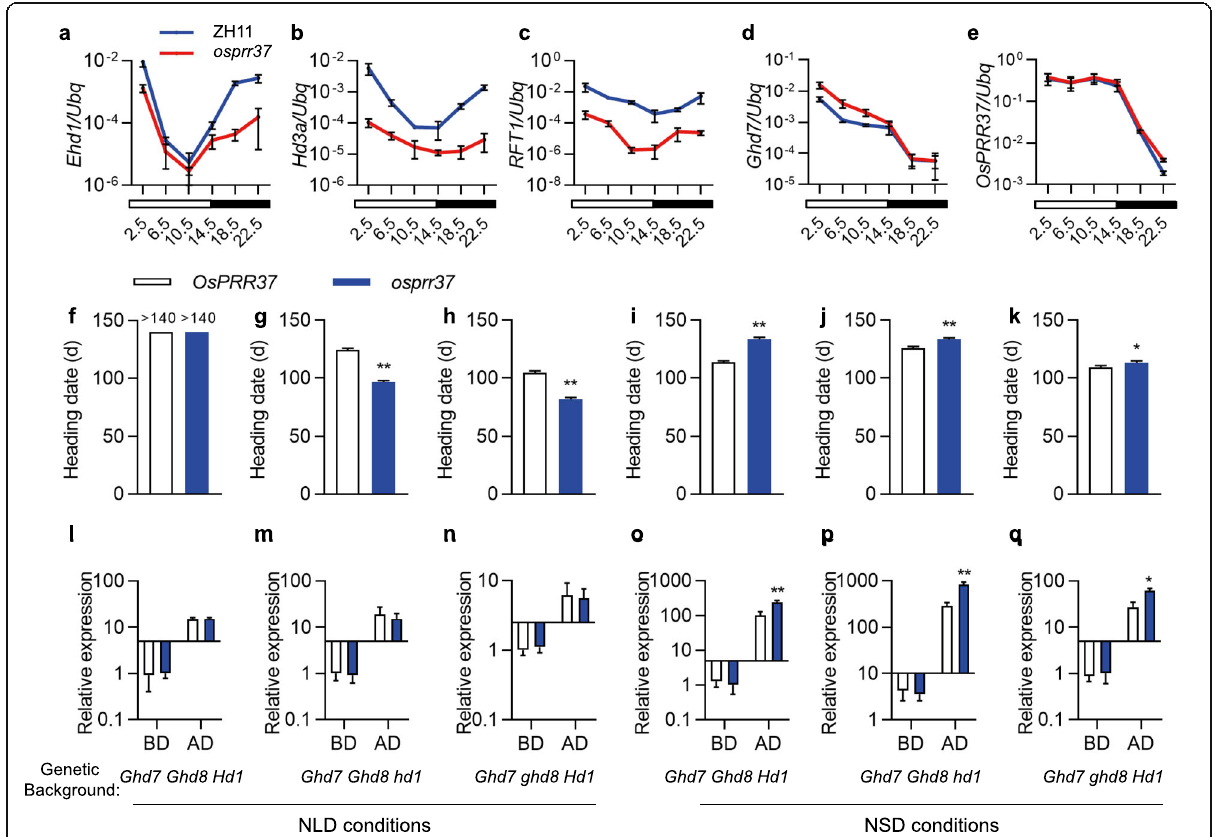
Fig. 3 Expression analysis of heading date genes in osprr37 mutant and different NILs. a-e Log 10 -transforemed expression levels of indicated genes in leaves of 40-d-old plants under controlled LD conditions were determined by quantitative real-time PCR (qRT-PCR) and shown as mean ± SD of three replicates. Rice ubiquitin gene (Os02g0161900) was used for normalization. f-k Comparing of heading date of near isogenic lines of OsPRR37 in Zhenshan 97 background harboring different alleles of Ghd7 , Ghd8 and Hd1 under NLD ( f-h ) and NSD ( i-k ) conditions. i-q Comparing of Ghd7 expression in near isogenic lines indicated in f-k under controlled environments. Expression level of Ghd7 were detected 2.5 h before (BD) and after dawn (AD) and shown as Log 10 -transforemed style. Leaves of 40-d-old plants under indicated conditions was collected and used for quantitative real-time PCR (qRT-PCR). Data was shown as mean ± SD of three replicates. Rice ubiquitin gene (Os02g0161900) was used for normalization. *, P < 0.05; **, P < 0.01; t